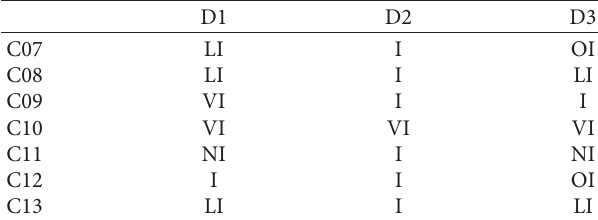
Table 5: Linguistic terms of expert’ viewpoint in economic criteria.